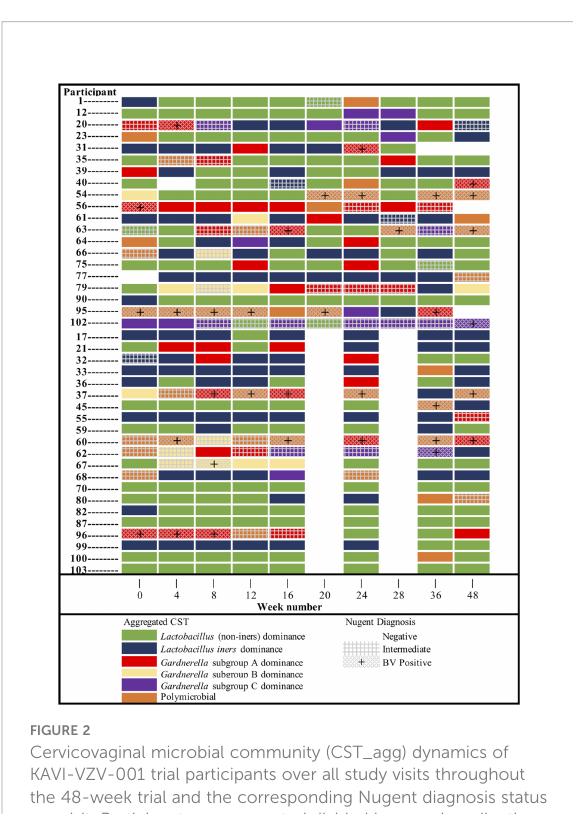
FIGURE 2 Cervicovaginal microbial community (CST_agg) dynamics of KAVI-VZV-001 trial participants over all study visits throughout the 48-week trial and the corresponding Nugent diagnosis status per visit. Participants are presented divided by sample collection groups as per the main study